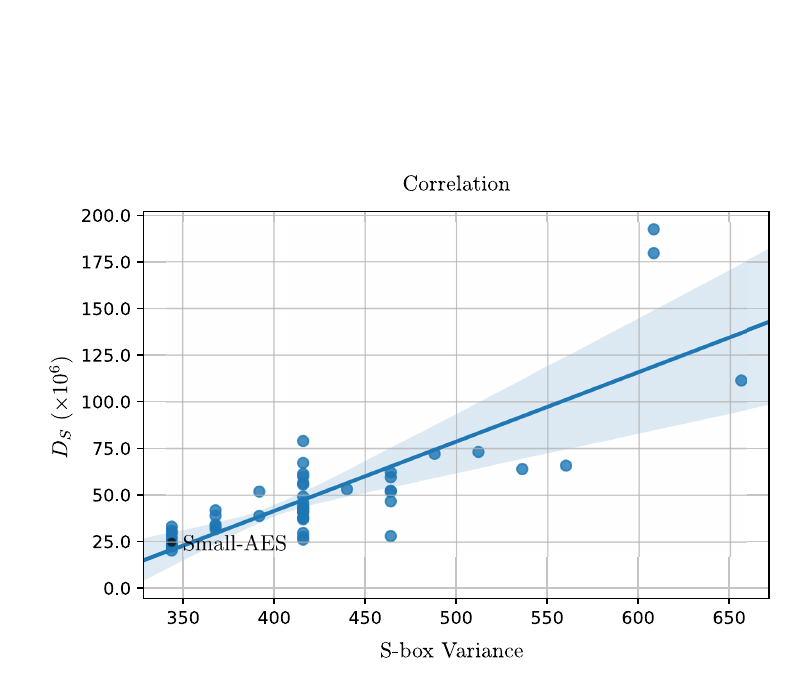
Figure 22: Correlation of D S , i.e., the squared distance to the expected number of collisions over all output-cell positions and the variance of our tested S-boxes.